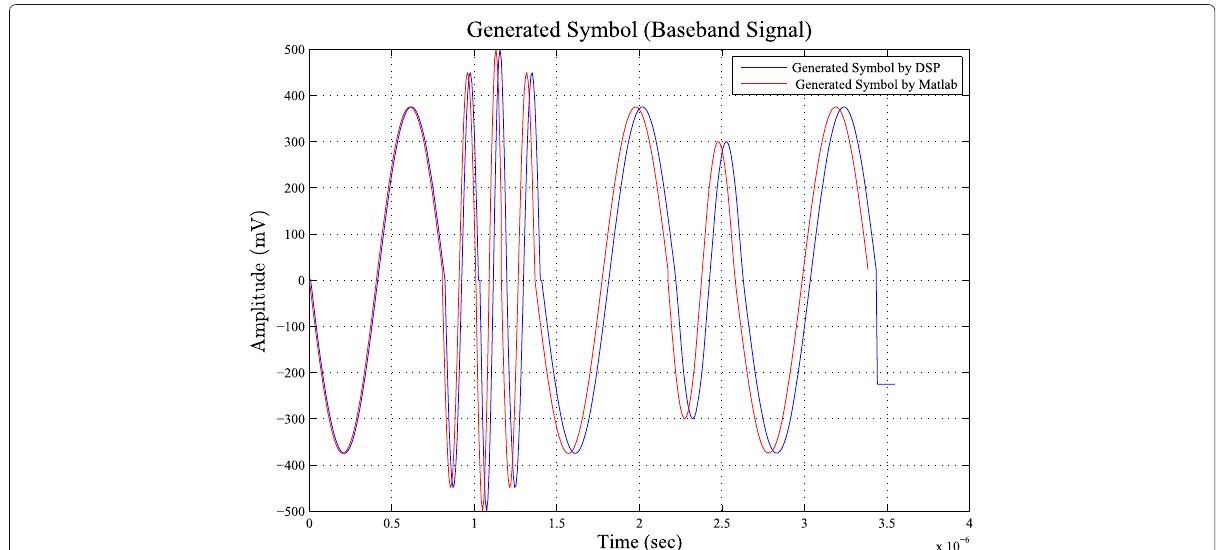
Fig. 6 Synthetic signal (baseband signal) by using Matlab compared with the real synthetic signal generated by the hardware. F s = 122.88